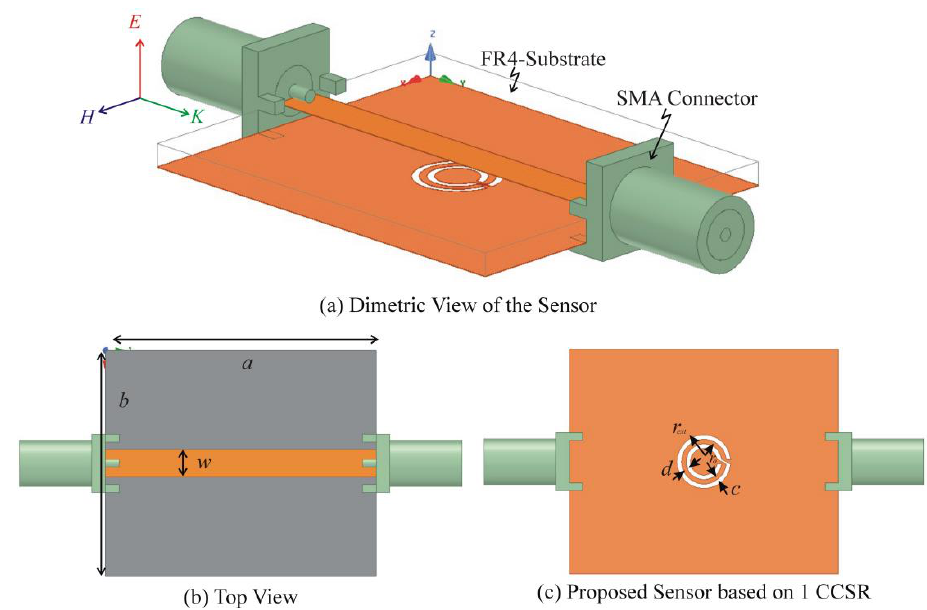
Figure 1. ( a ) Sensor design based on FR4 epoxy substrate ( h = 1 mm). ( b ) Top view of the sensor ( a = 30 mm, b = 25 mm, w = 3 mm). ( c ) Bottom view of the sensor ( r ext = 3 mm, r 0 = 1.5 mm, c = d = 0.5 mm).